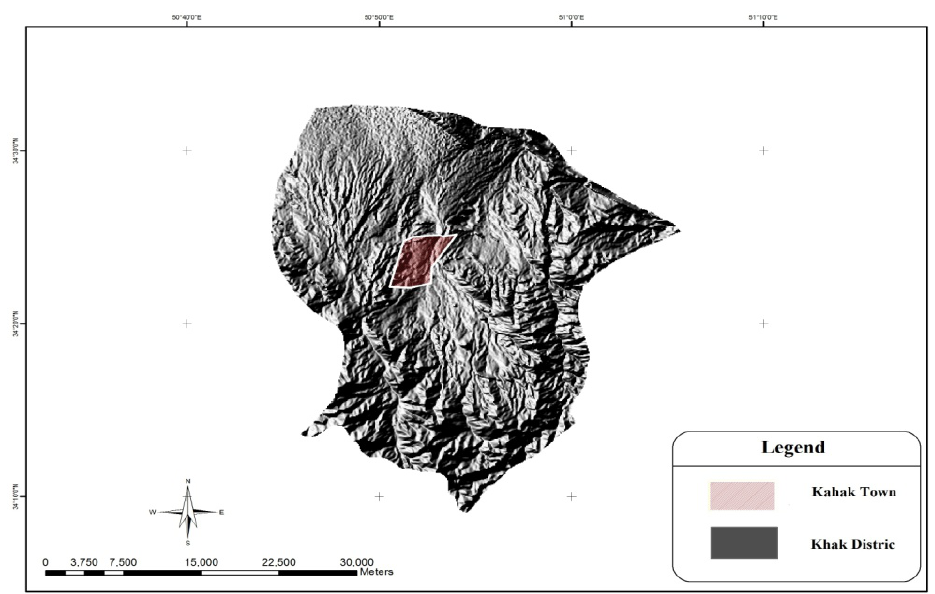
adopted from Kahraman et al.17 (x) is fuzzy function, (b) is the central value with 𝐩ʹ� ~ 𝛍 𝐏